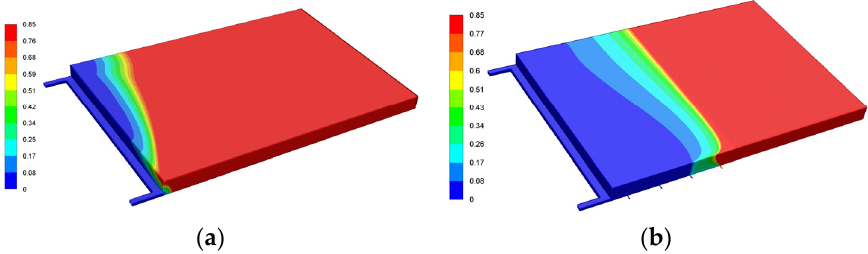
Figure 3. The distribution of methane concentration. ( a ) Without large-diameter boreholes. ( b ) With large-diameter boreholes.